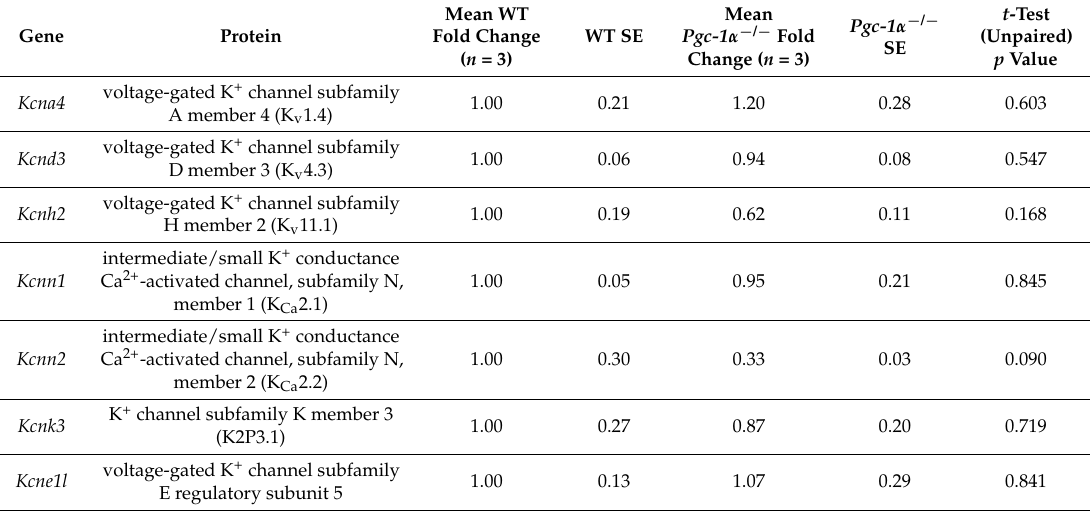
Table 5. The mean gene fold changes underlying channels relating to repolarisation in Pgc-1 α − / − compared to WT